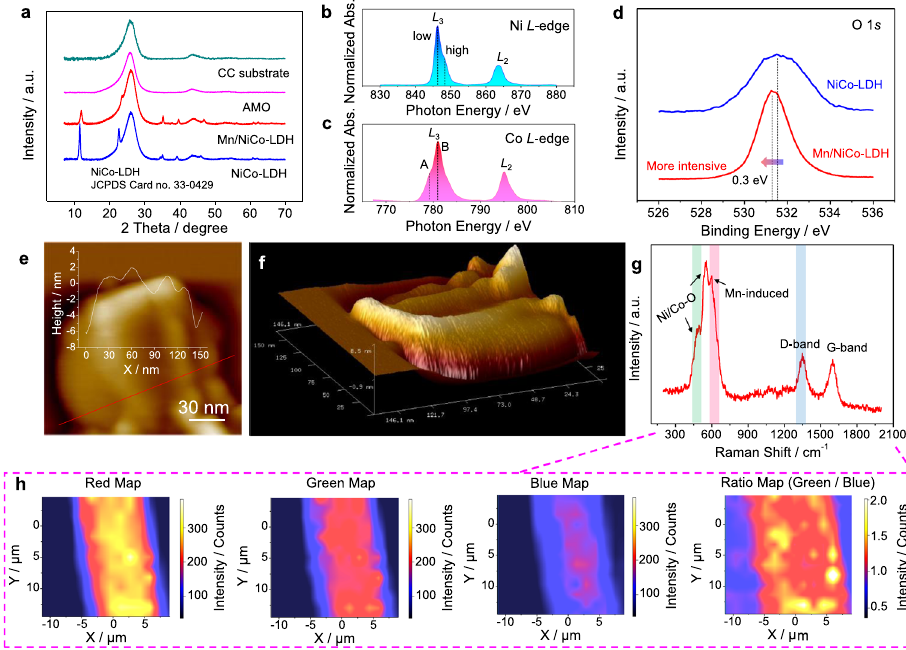
Fig. 2 Phase and bonding information analysis. a XRD patterns of the pristine CC substrate, as well as the as-formed AMO, Mn/NiCo-LDH and NiCo- LDH; Ni L -edge ( b ) and Co L -edge ( c ) sXAS spectra of the Mn/NiCo-LDH; d O 1 s XPS spectra of Mn/NiCo-LDH and NiCo-LDH; AFM 2D ( e ) and 3D ( f ) images of Mn/NiCo-LDH nanosheets, the inset in e is the height pro fi t; g Raman spectrum of Mn/NiCo-LDH, and h the corresponding Raman mapping